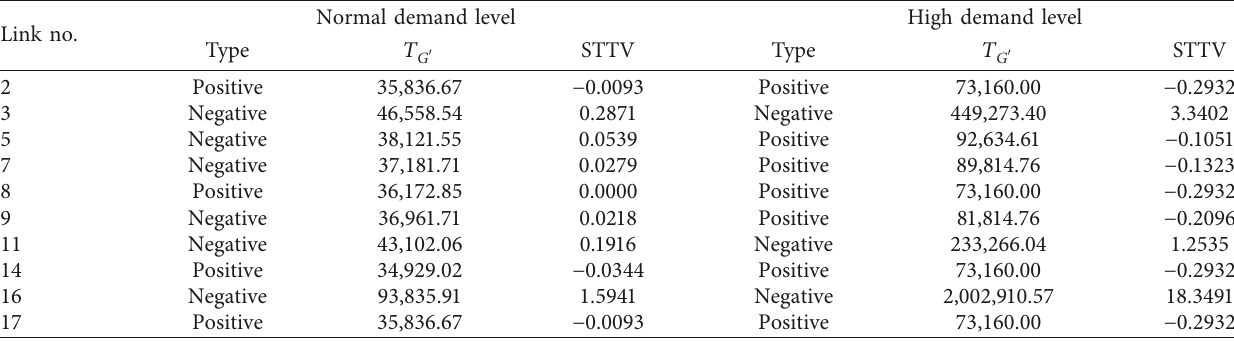
Table 7: STTV for the transportation system.